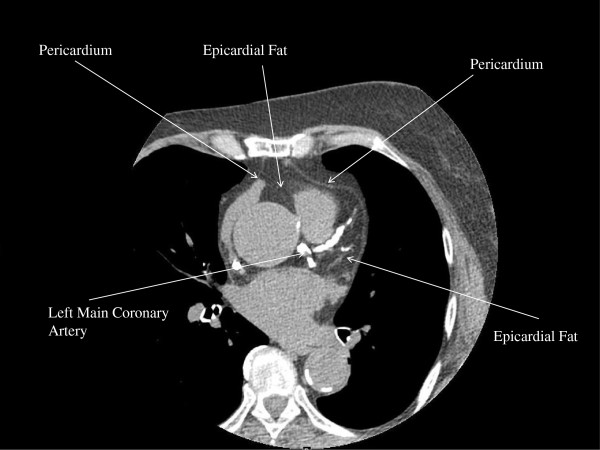
Axial MSCT scan at the left of the left main coronary artery demonstrating relevant landmarks for the measurement of single slice epicardial fat volume (ssEFV) in a 72 year old female chronic kidney disease patient.